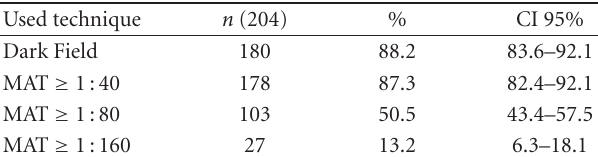
Table 3: Leptospirosis prevalence and contact with domestic